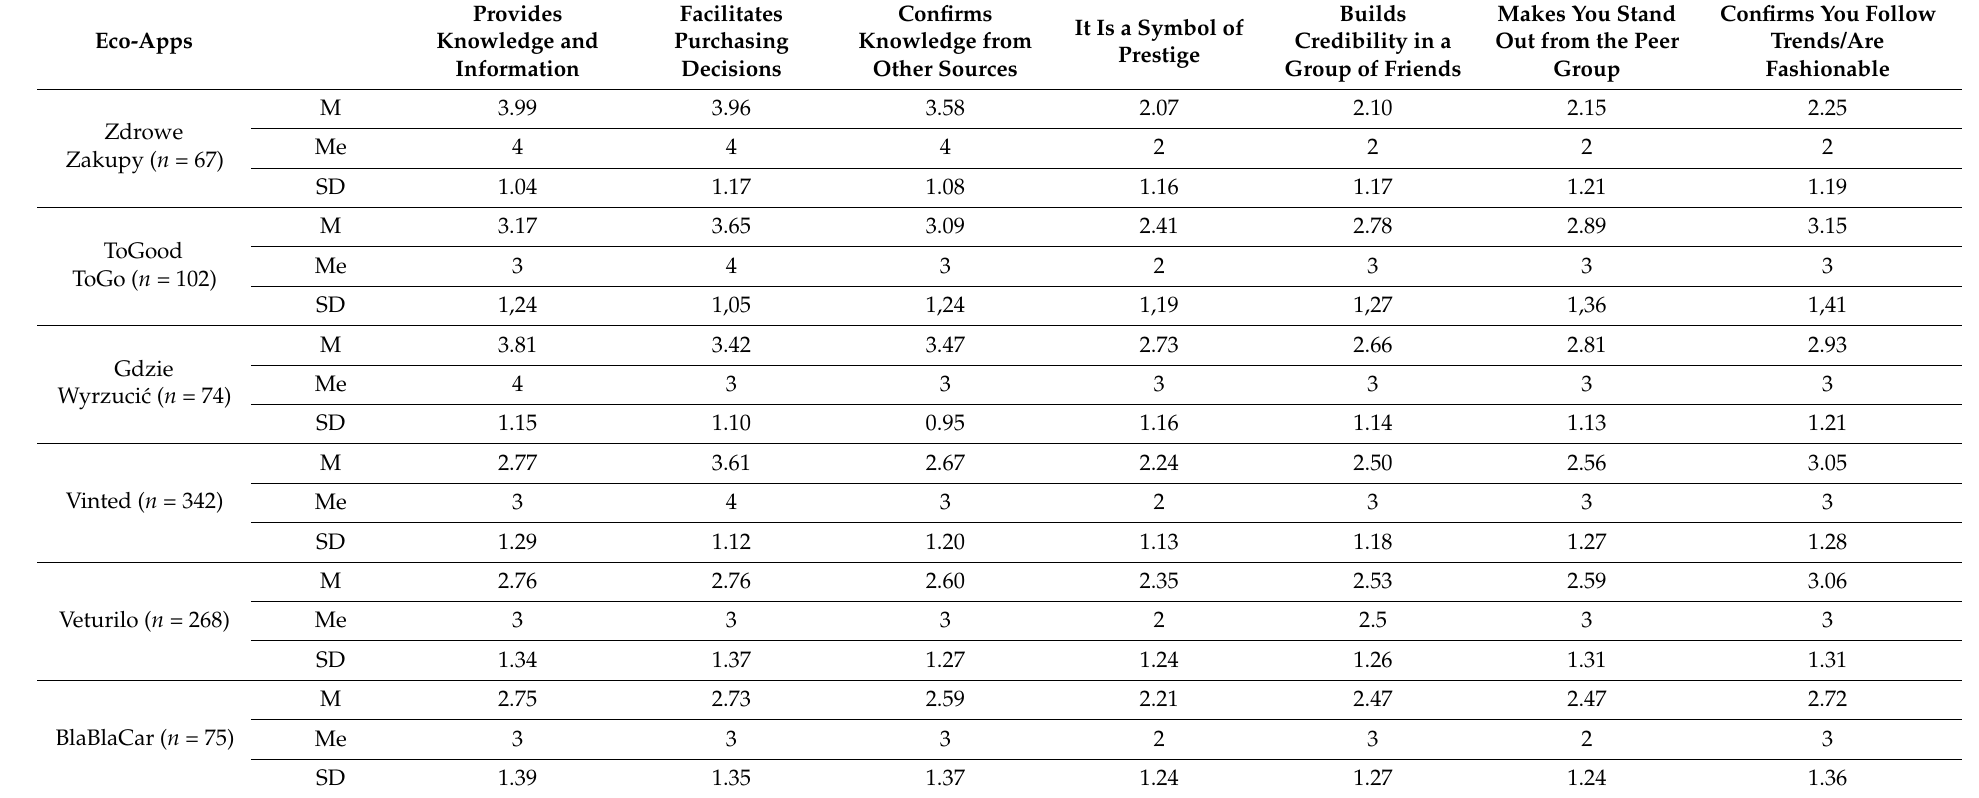
Table 6. Assessment of the usefulness of individual eco-apps on a five-point Likert